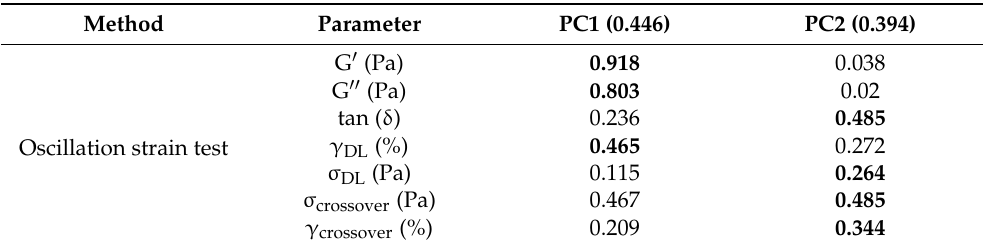
Table 7. Values of cos 2 for each parameter for the two axes of PCA oscillation strain test (the significant values are in bold).